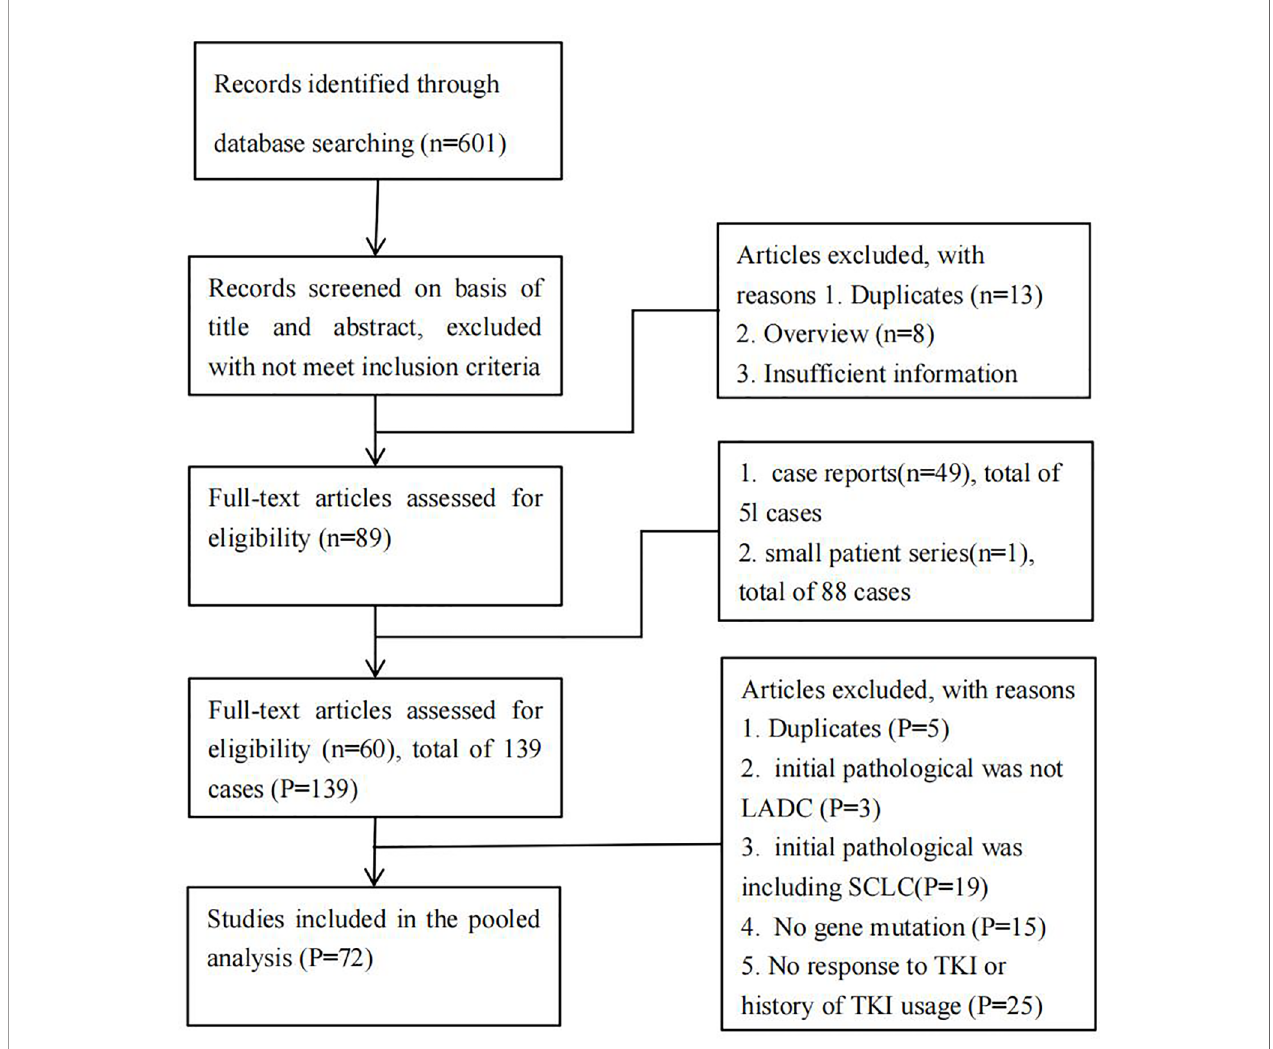
FIGURE 1 | PRISMA fl